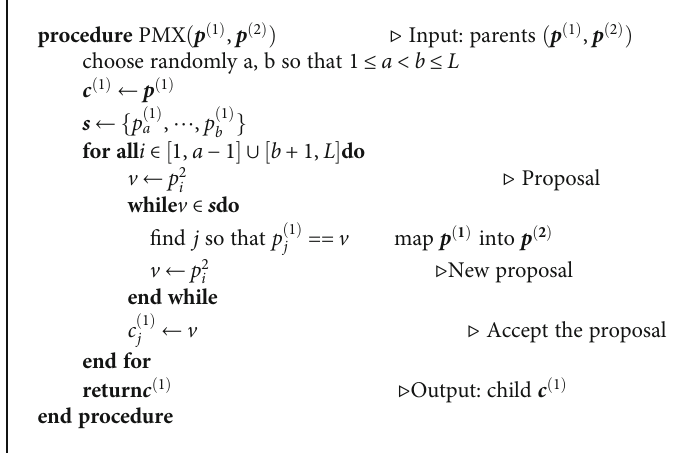
Algorithm 1: Partially Matched Crossover (PMX)